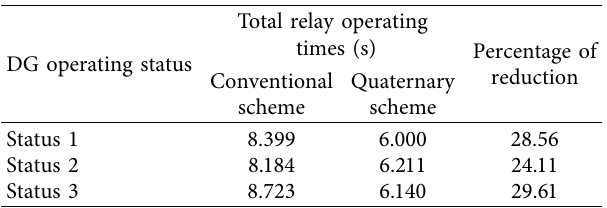
Table 12: Comparison of the total relay operating times of different protection schemes in grid-connected